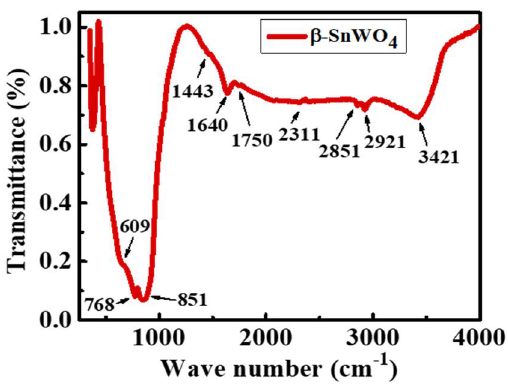
Figure 7. Fourier transforms infrared (FTIR) spectrum of β-SnWO 4